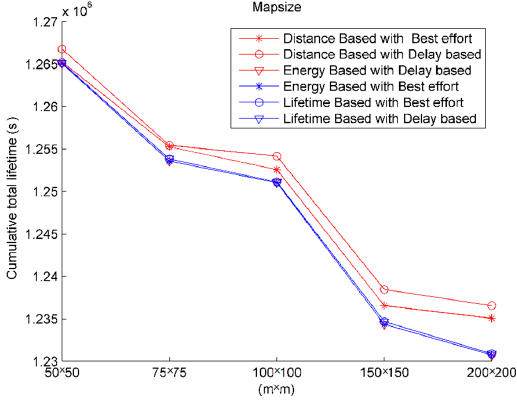
Figure 16. The analysis results of different density effect.